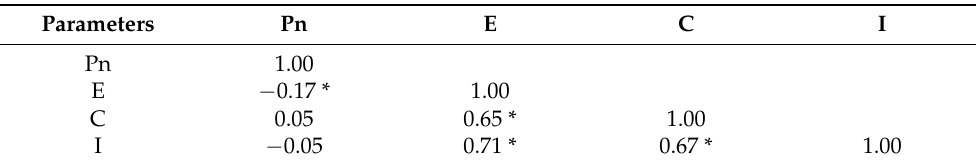
Table 5. The correlations between the studied physiological parameter of maiden apple trees in the year